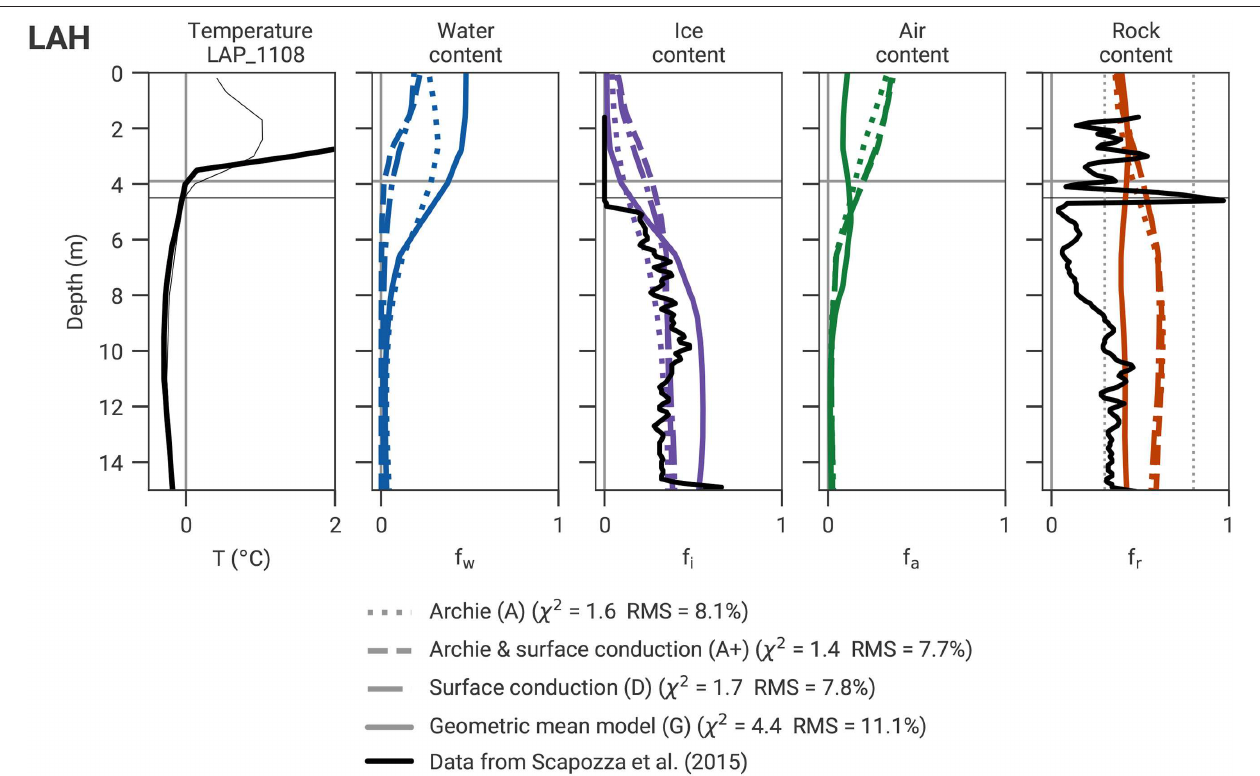
FIGURE 10 | Borehole temperature measured in LAP_1108 and corresponding four-phase constituents estimated by the joint inversion of LAH, including the corresponding data derived from nuclear logging performed by Scapozza et al. (2015) at Lapires. 0 ◦ C temperature lines and thaw depths are marked by gray lines, respectively (23 August 2010, date of geophysical surveys). The black horizontal lines as well as the thin temperature curve correspond to the date of the nuclear logging data (30 September 2010). Vertical dotted lines mark the rock constraint limits (from the prescribed porosity